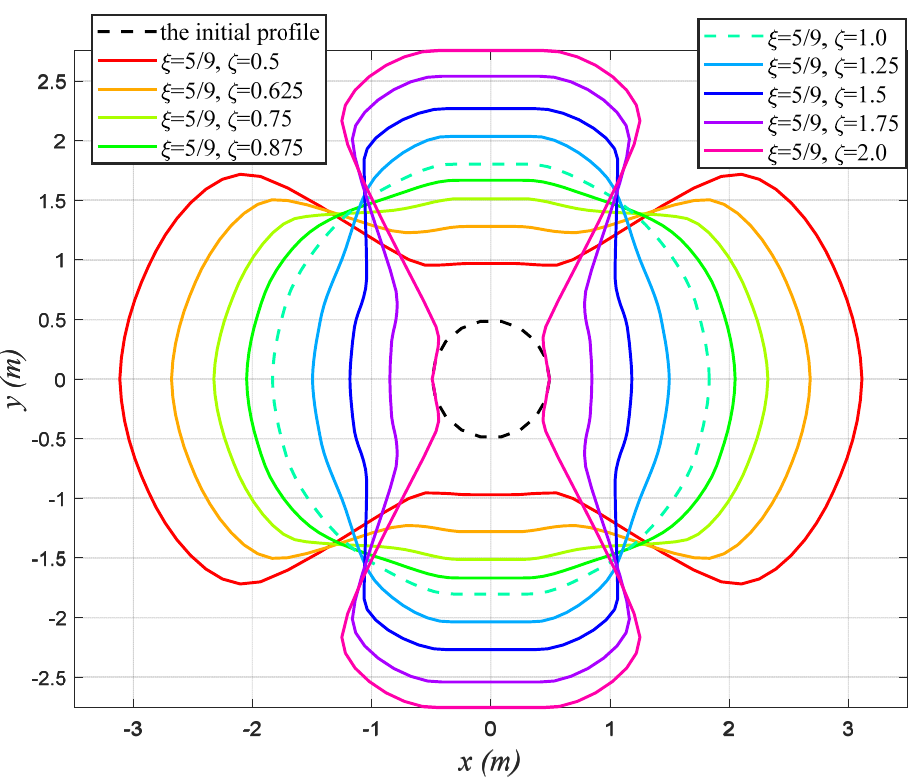
Figure 16. Fracture profiles on the plane 𝑥𝑜𝑦 of Group 2 experiments under 𝜉 = 3 9⁄ at the mo- ment = 20 s .